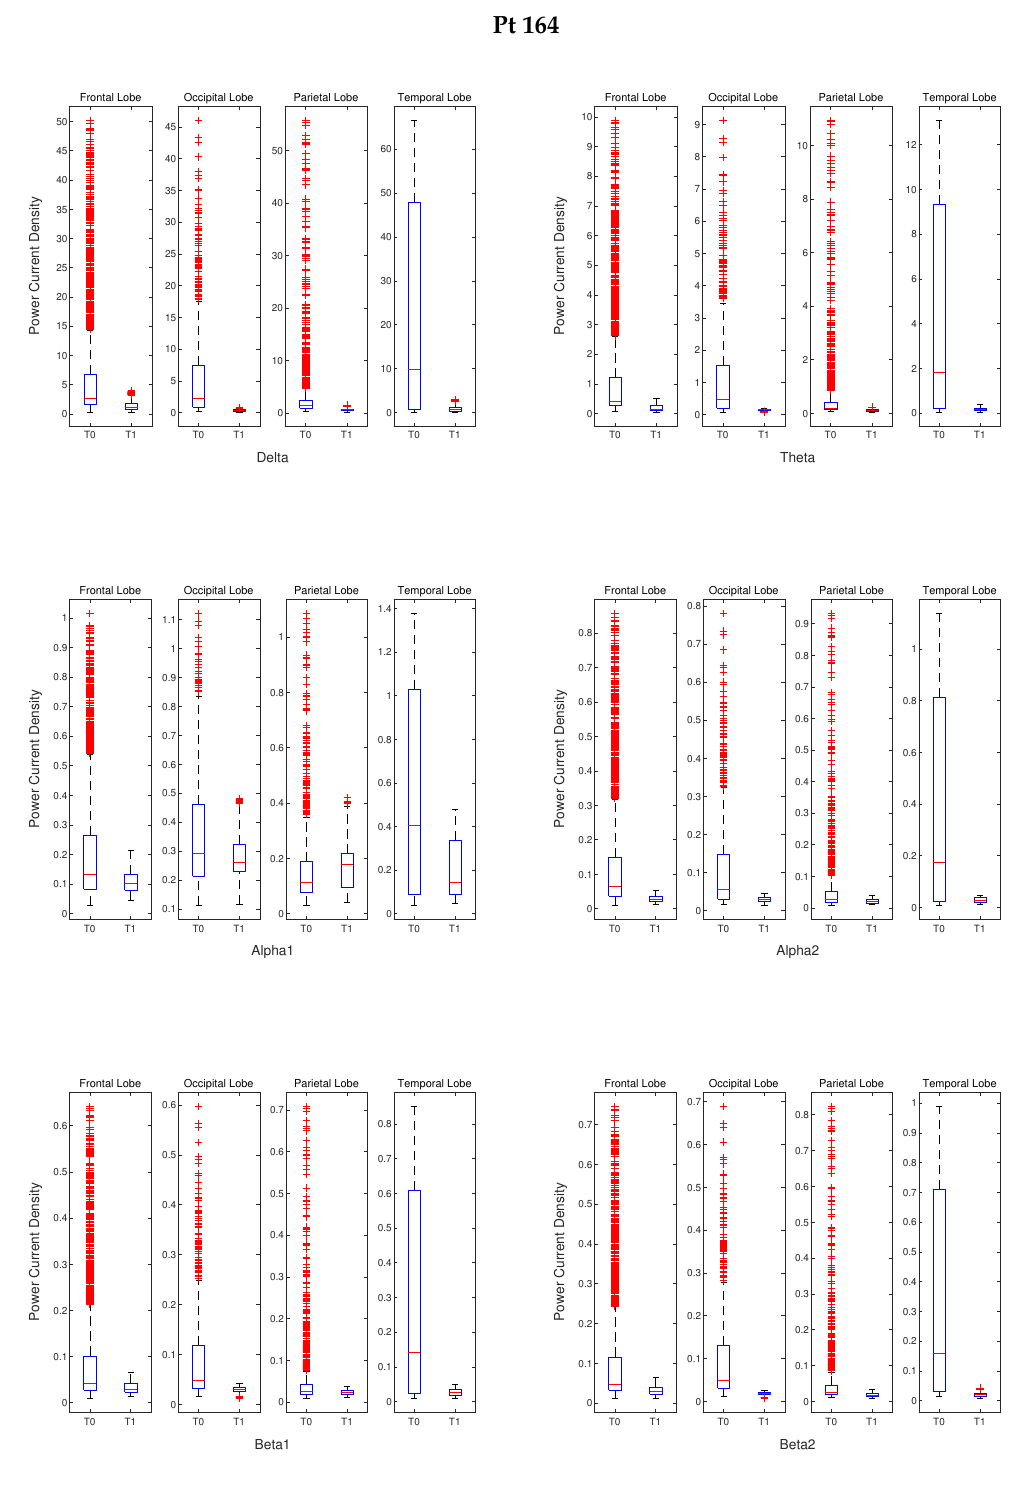
Figure 7. Boxplot of the power current density of patient 164 at time T0 and T1 for each frequency sub-band and each region of interest (frontal, occipital, parietal, and